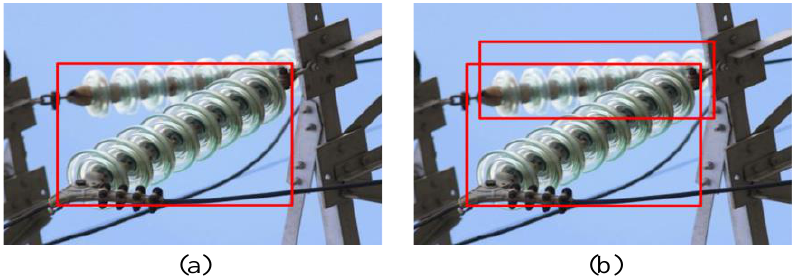
Figure 3. Detection results with ( a ) NMS and ( b )